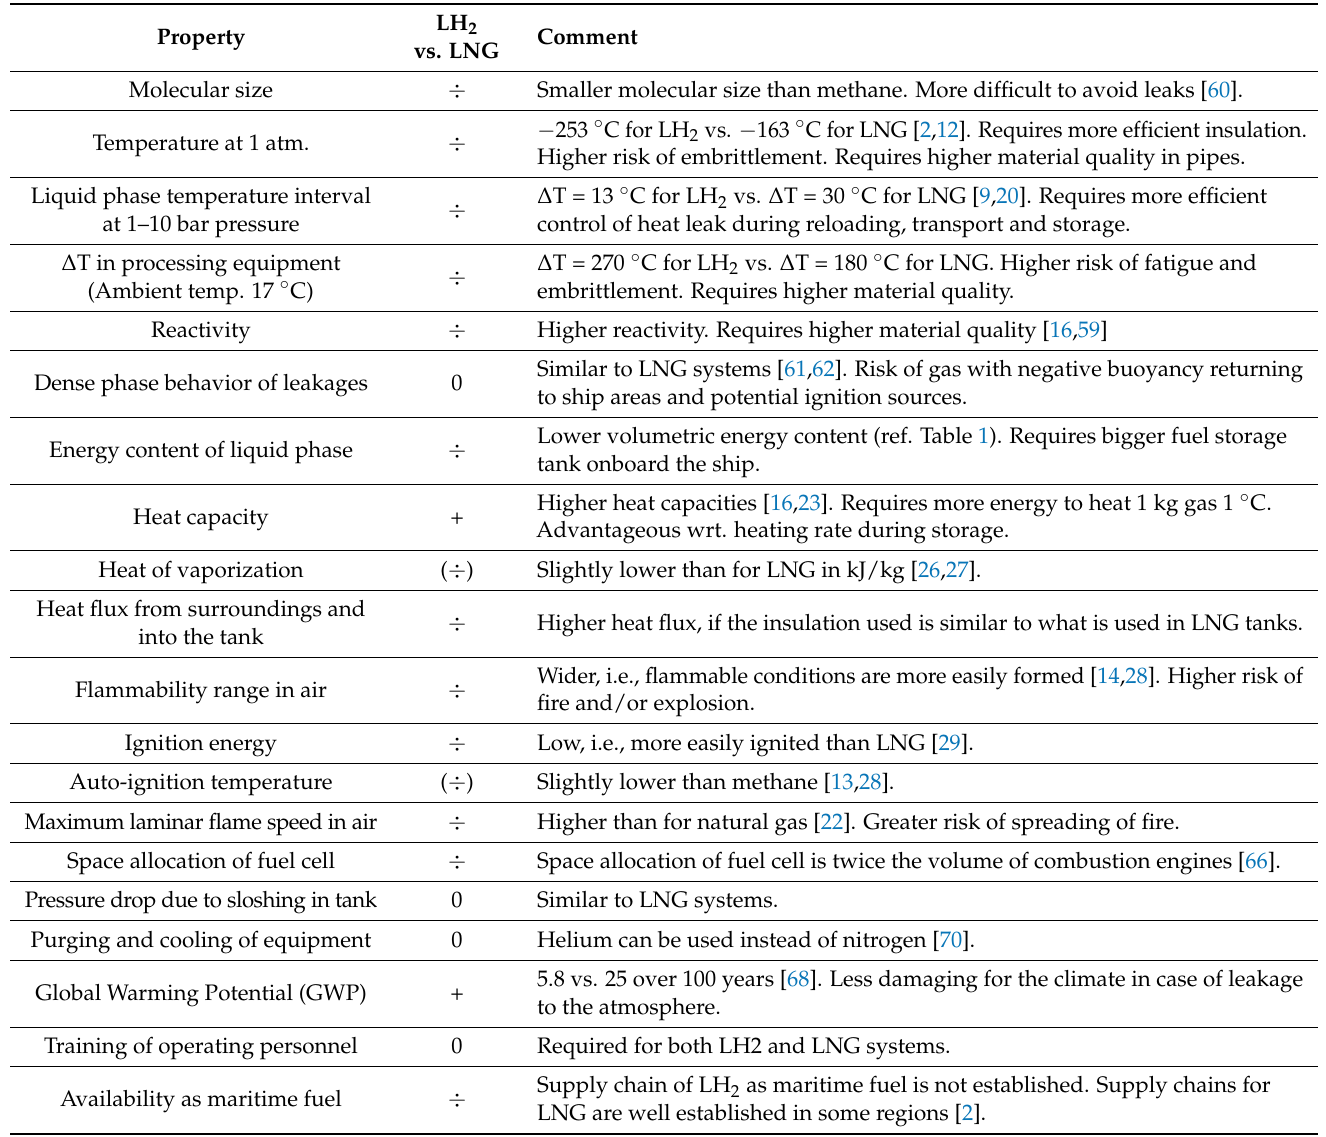
Table 3. The table shows a summary of the discussion of the applicability of liquefied hydrogen (LH 2 ) as a maritime fuel. In the table, LH 2 is compared to liquefied natural gas (LNG) as a maritime fuel. Only properties where LH 2 and LNG show significant differences are listed here. (“0”: The challenges are similar for LH 2 and LNG systems. “ ÷ ”: The given characteristics constitutes a disadvantage for LH 2 systems as compared to LNG systems. “+”: The given characteristics constitutes an advantage for LH 2 systems as compared to LNG